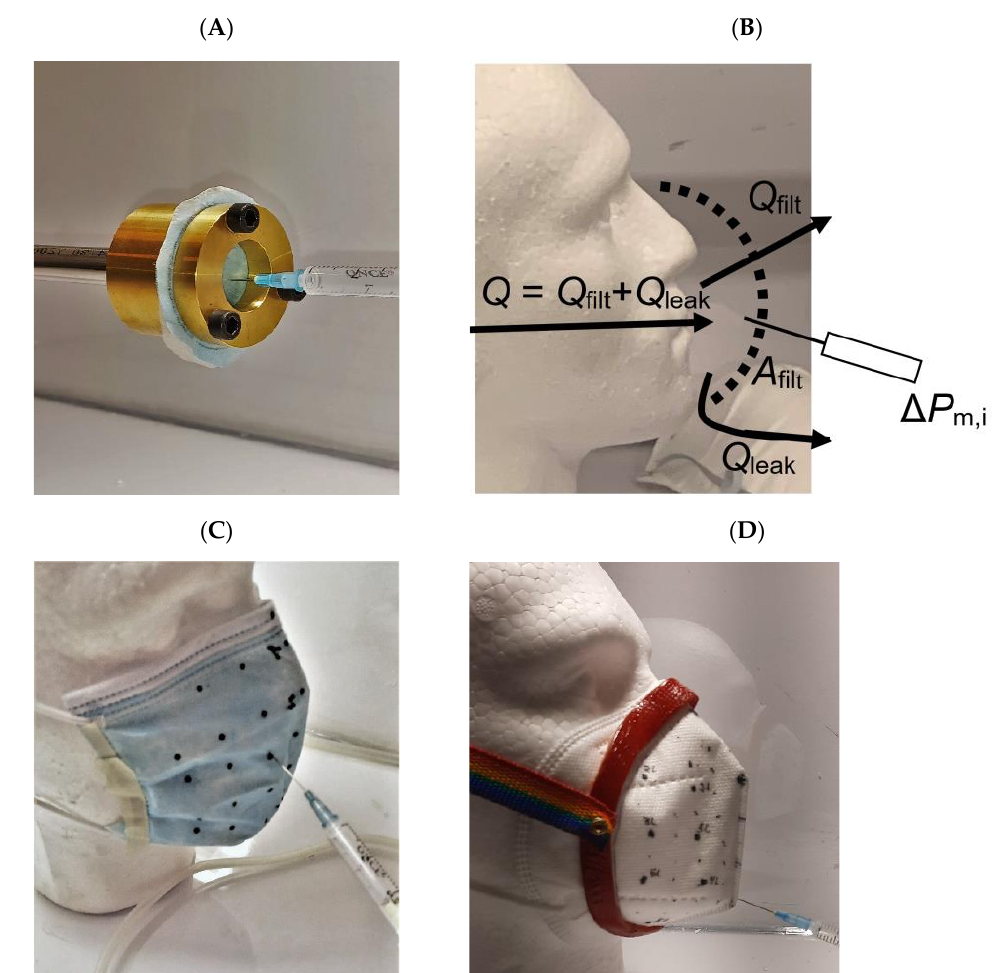
Figure 2. ( A ): Adapter with filter sample and syringe pressure probe. ( B ): Definition of filter and leak flows showing schematic use of pressure probe inserted through the filter material to measure the local pressure ∆ P m,i under the mask. ( C ): M1 mask in ‘casual’ mount showing marked array of 28 locations for measuring local pressure distribution under the mask. ( D ): M2 mask in ‘tight’ mount with GRP fitter showing marked array and pressure probe.